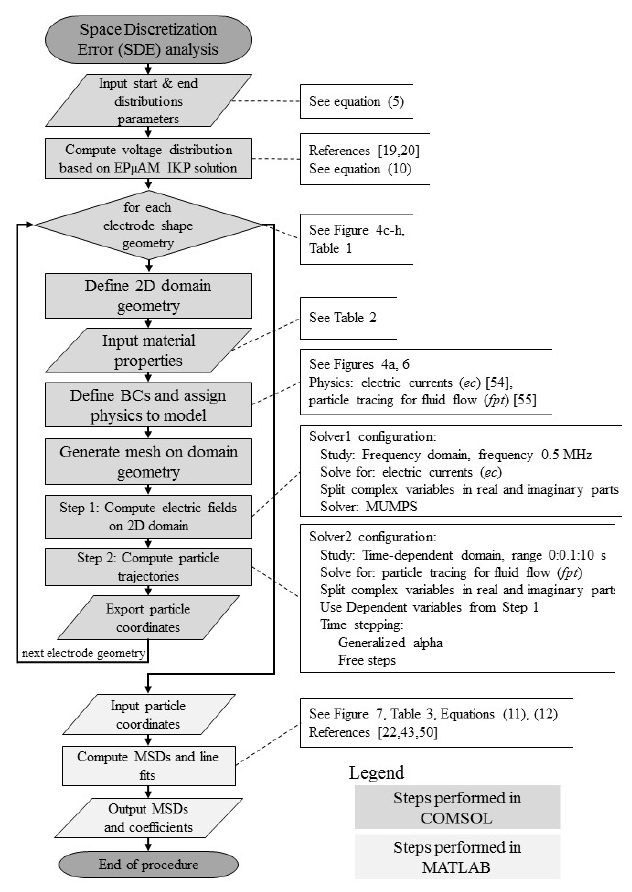
Figure 5. Space discretization error analysis flowchart.